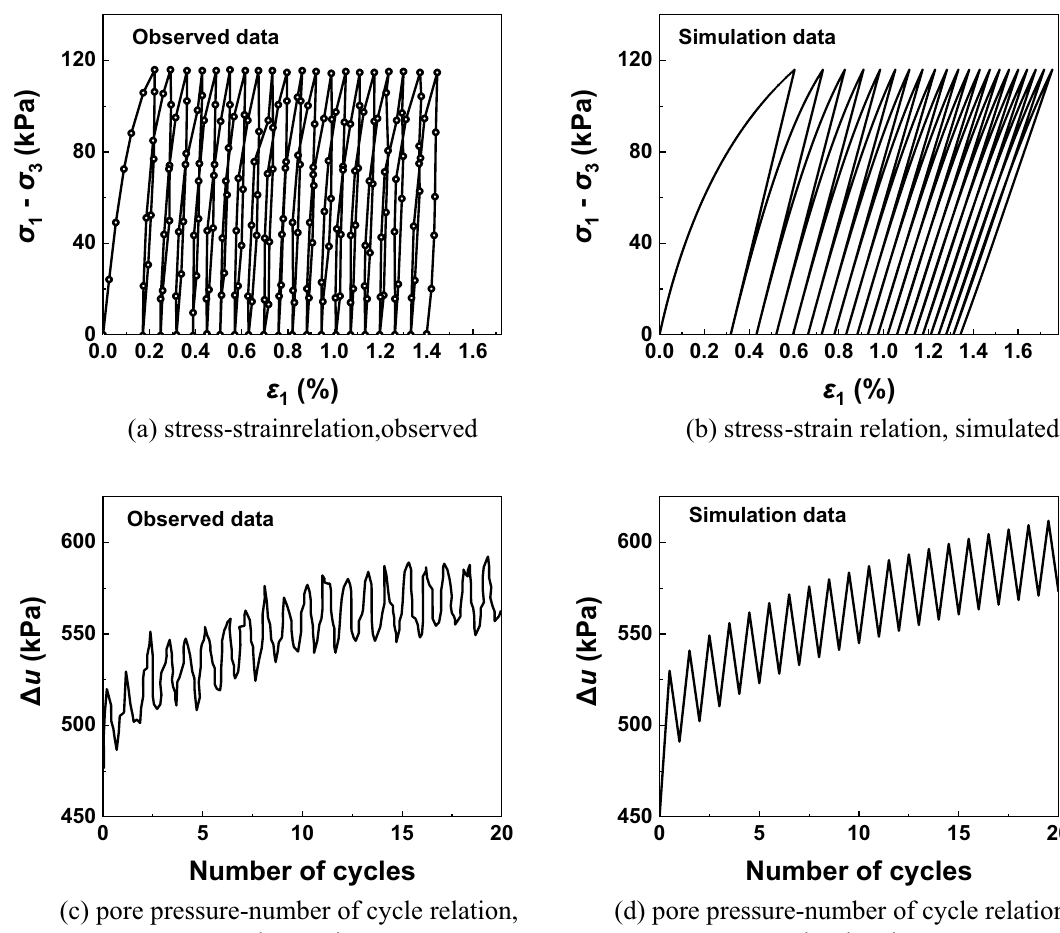
Figure 9. Model predictions and experiment results of Commercially available clay under undrained